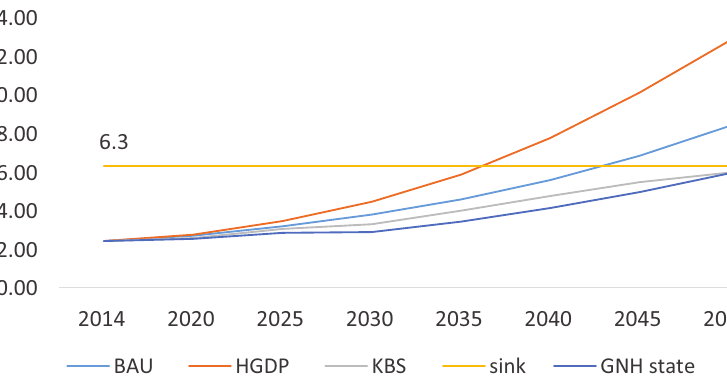
Figure 3. Emission variation by source under different scenarios.